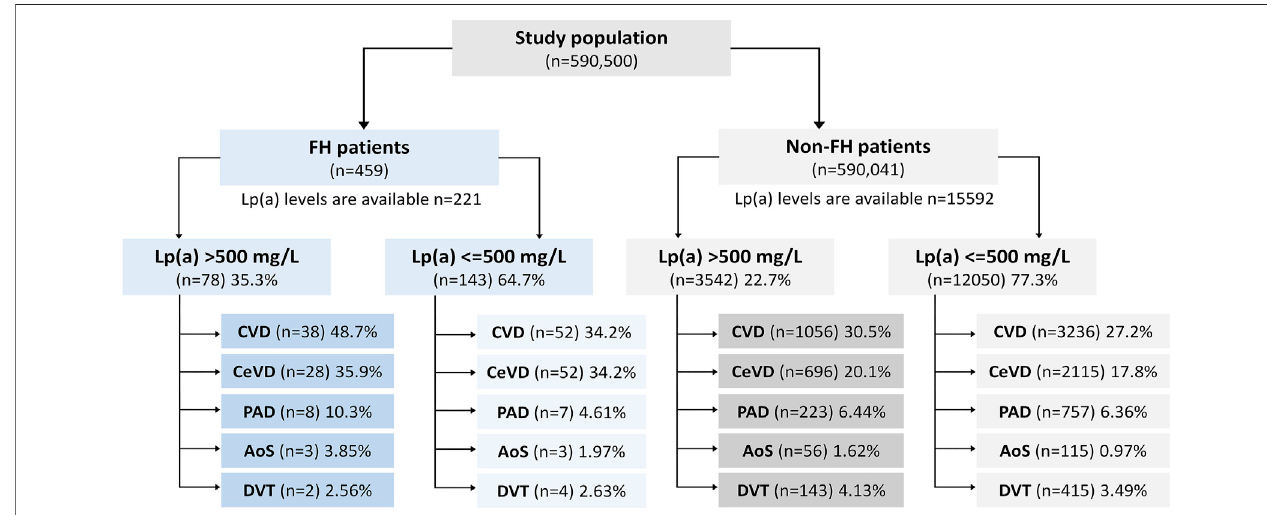
FIGURE 1 | Flowchart showing the structure of the study population, number of enrolled patients, and how the patients were divided into the groups, and subgroups.